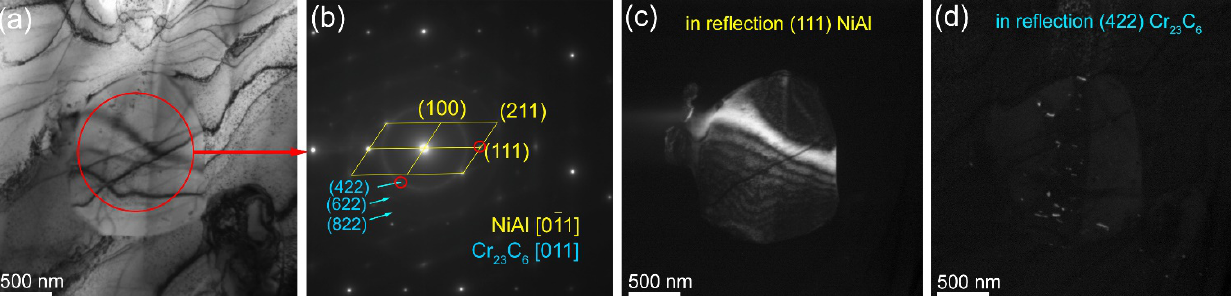
Figure 9. Bright-field TEM image of Ni-rich grains with fine precipitates in 15% Ud composite ( a – c ) and corresponding EDS element distribution maps ( d – l ). EDS element concentrations in zone 1 to 4 in ( c ). Table 2. EDS element concentrations in points indicated on the 15% Ud sample (Figure 9c).